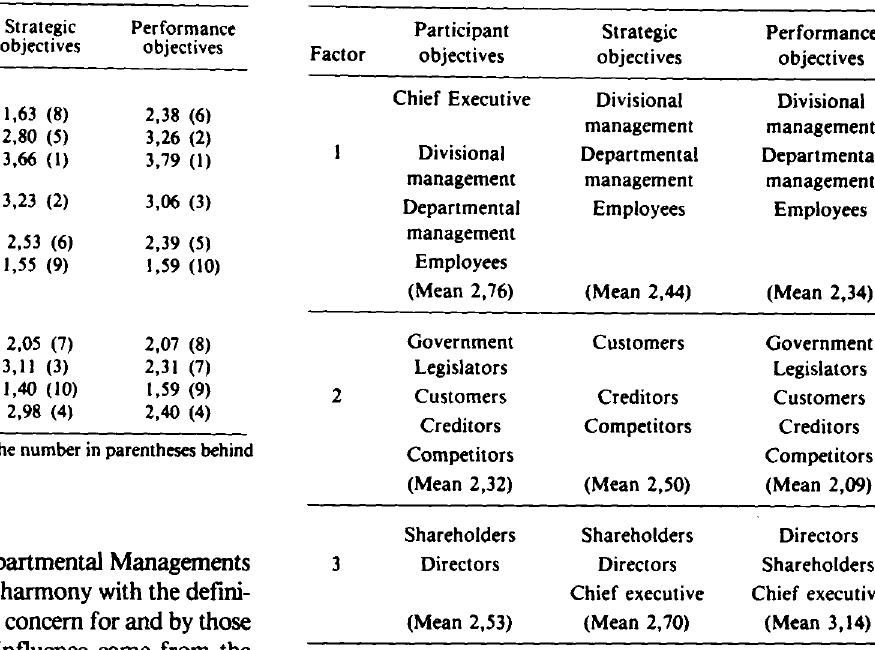
Table 7 Comparative factor groupings of the in- terest groups on the formulation of the three classes of